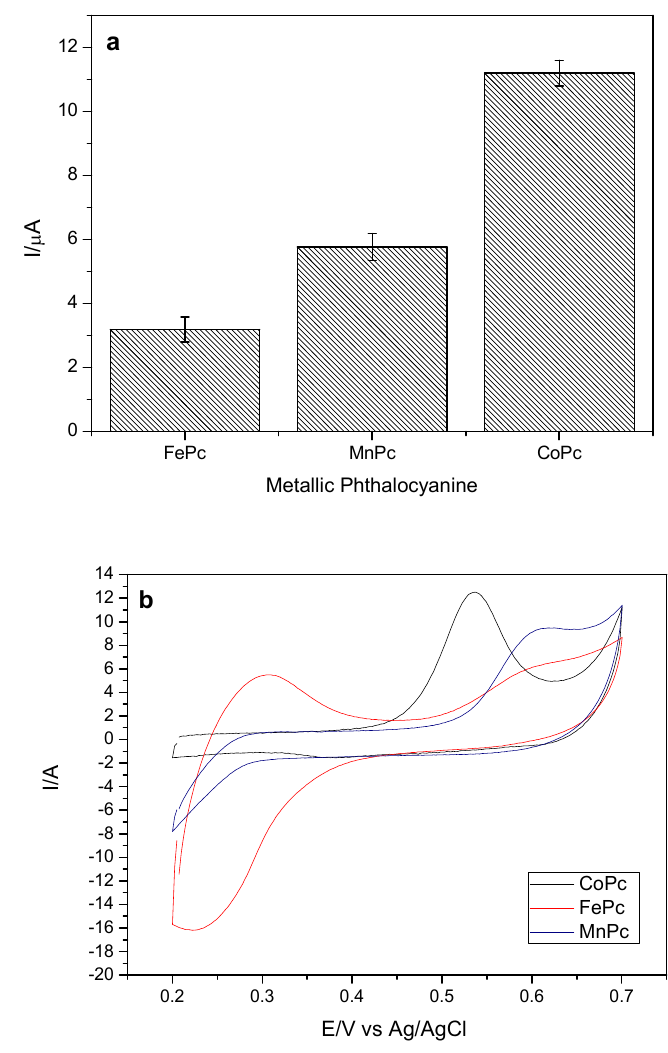
Figure 3. ( a ) Evaluation of Metallic Phthalocyanines in the presence of 175 μmol L −1 of ethinyl estradiol. ( b ) Cyclic voltammograms for different metal phases in the presence of 175 μmol L −1 of ethinyl estradiol. Buffer solution Phosphate 0.1 mol L −1 , pH 7.0. Cyclic voltammetry, scan rate 0.01 V s −1 .